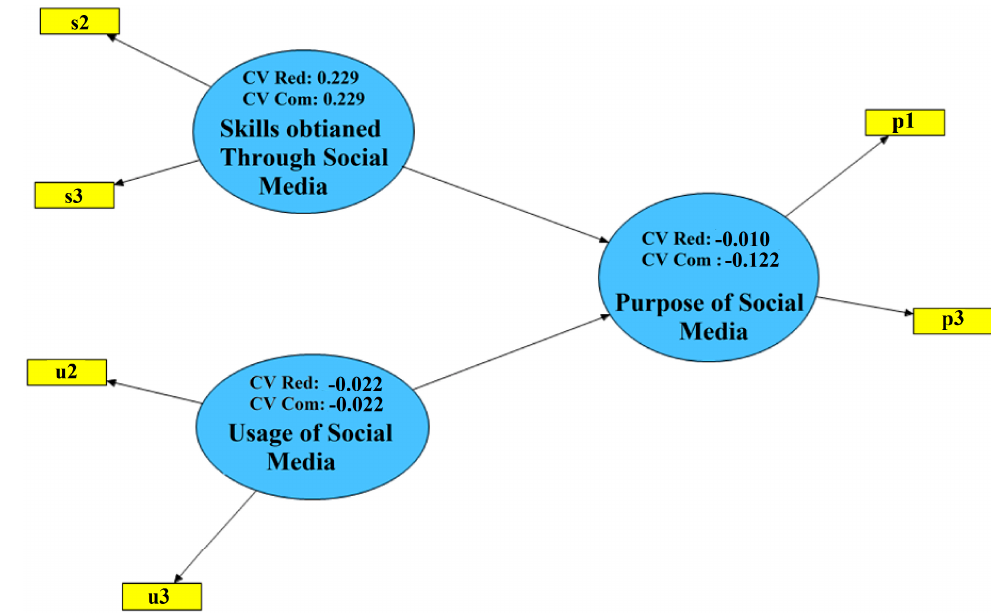
Figure 7. Blindfolding evaluation procedure for validating the predictive accuracy of the model.